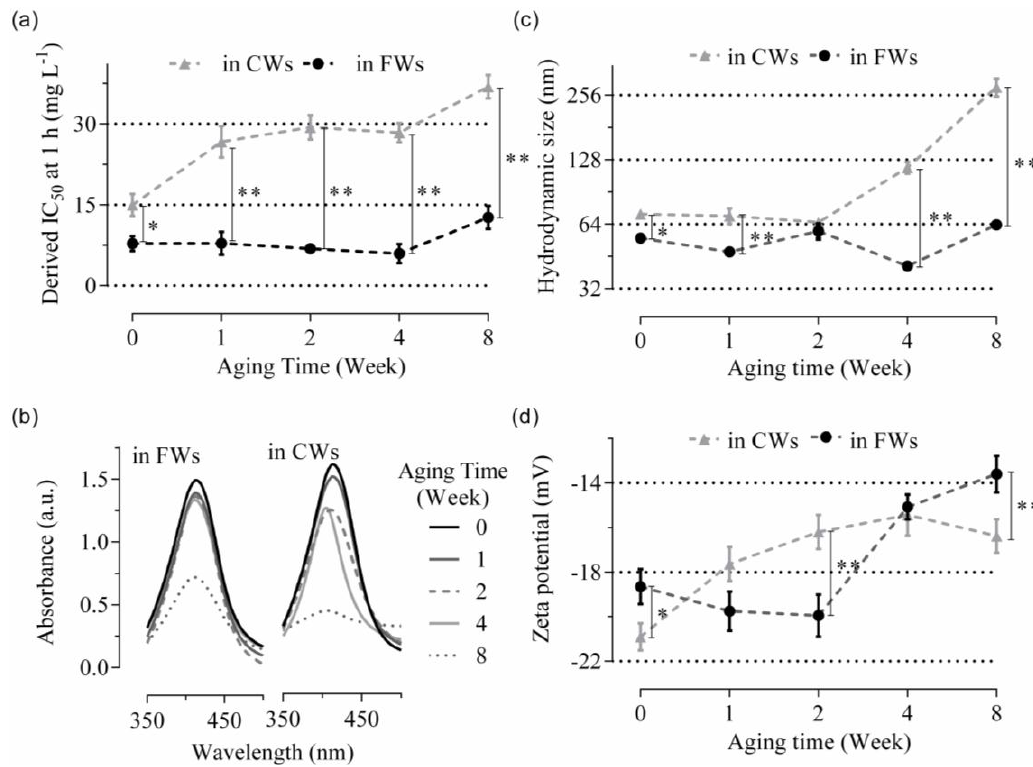
Figure 5. Effects of aging. Fate and toxicity of Ag NPs were tested after 0, 1, 2, 4 and 8 weeks of aging in FW and CW from Site 3. Derived IC 50 values at 1 h from ecotoxicity assays are presented in ( a ). Absorbance spectra obtained by UV-vis with Ag NPs at 10 mg·L −1 are presented in ( b ). Hydrodynamic size and zeta potential information, determined by DLS (Ag NPs at 10 mg·L −1 ), are presented in ( c ) and ( d ) respectively. Data are mean ± SEM ( n = 3), significant differences are represented as p < 0.1 (*) or p < 0.05 (**) following analysis with unpaired t-tests. Corresponding results obtained in artificial wastewater (AW) are presented in Supplementary Materials (Figure S7).